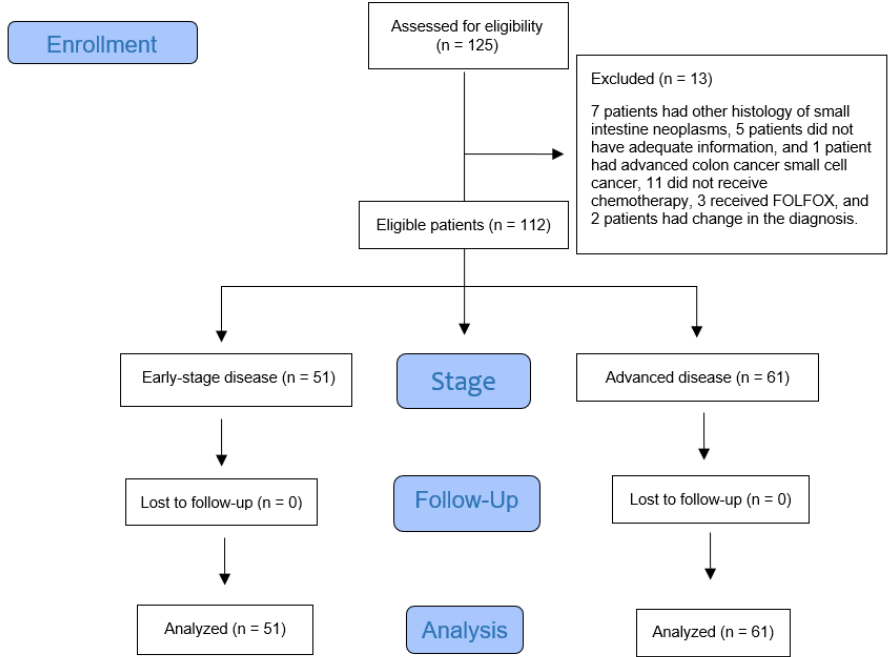
Figure 1. Flow diagram of eligible patients with small intestine adenocarcinoma cancer who were treated with two different combination chemotherapy regimens during the study period. Table 1. Baseline characteristics of the entire cohort and subgroups of patients with early stage (stage I, II, and III) and advanced disease (stage IV or unknown) with small intestine